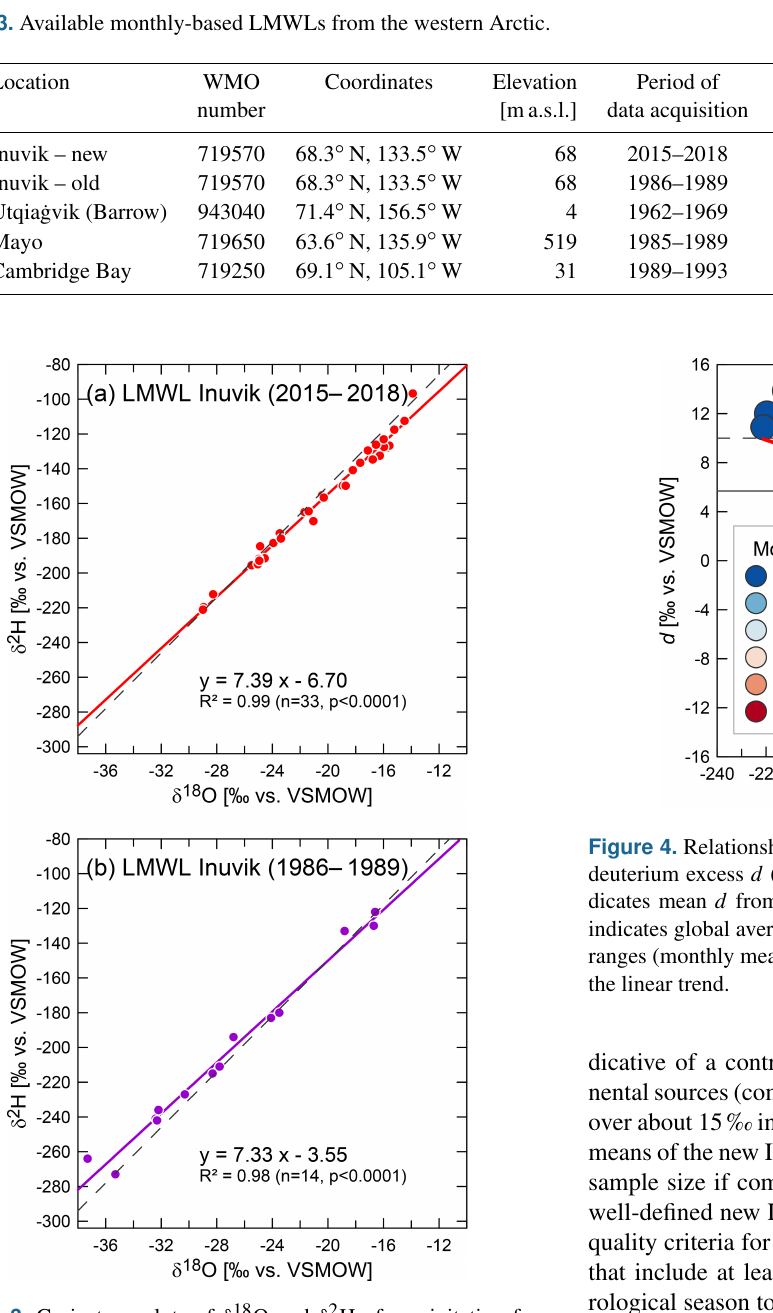
Figure 3. Co-isotope plots of δ 18 O and δ 2 H of precipitation for Inuvik (NT, Canada). (a) New ( n = 34, 2015–2018) local meteoric water line. (b) Old ( n = 14, 1986–1989) local meteoric water line. Dashed line represents the global meteoric water line.